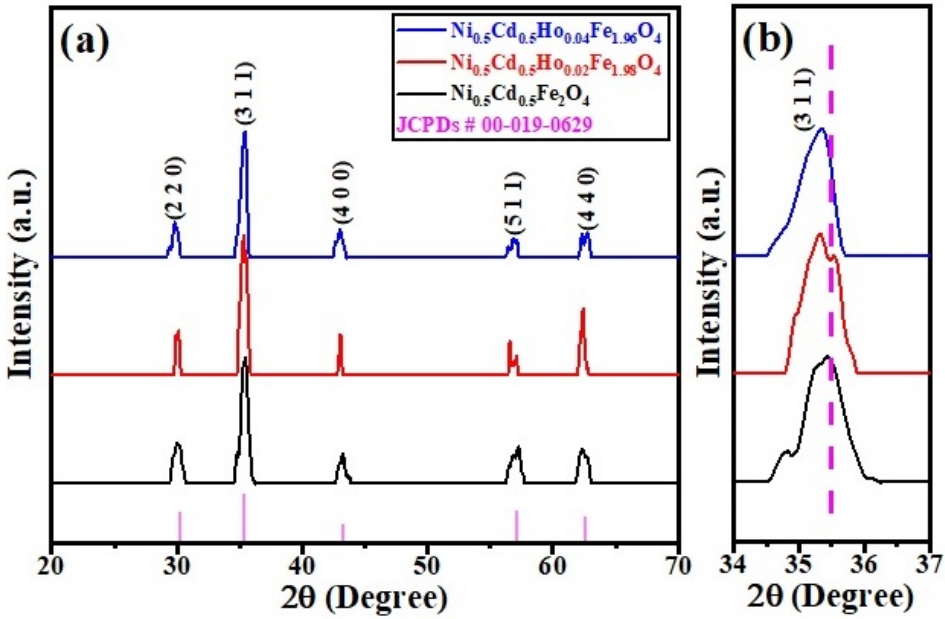
Figure 1. ( a ) XRD patterns of Ni 0.5 Cd 0.5 Ho x Fe 2-x O 4 (x = 0, 0.02, and 0.04). ( b ) zoomed view of (3 1 1) peak shifting toward the lower angle.